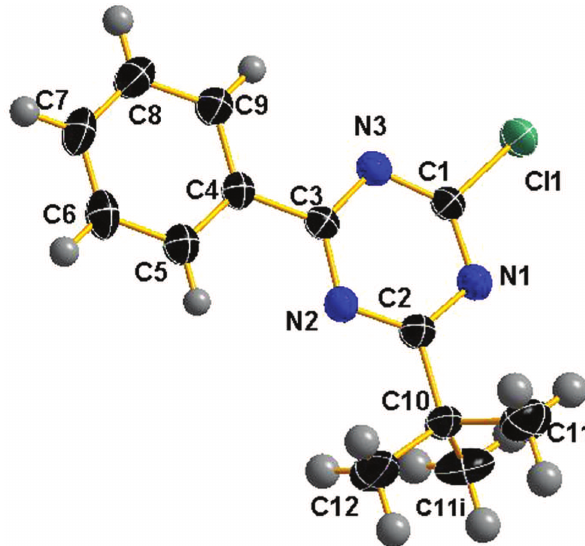
Table 1: Data collection and